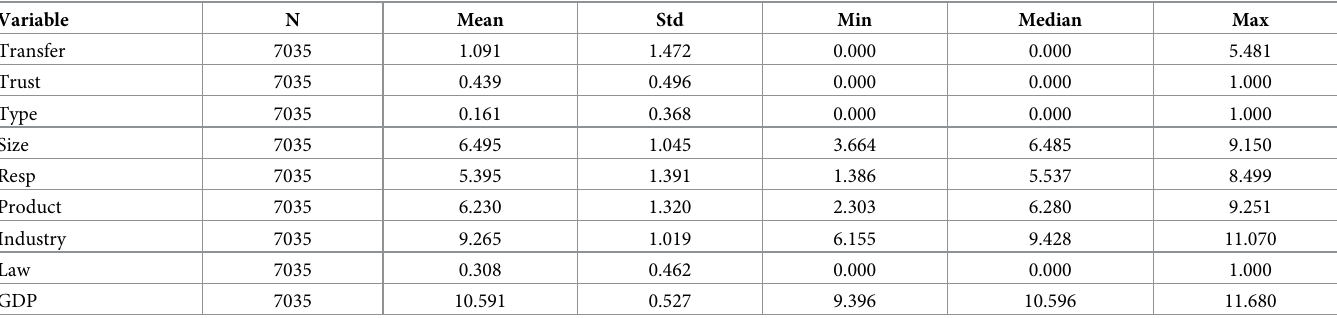
Table 1. Summary statistics.